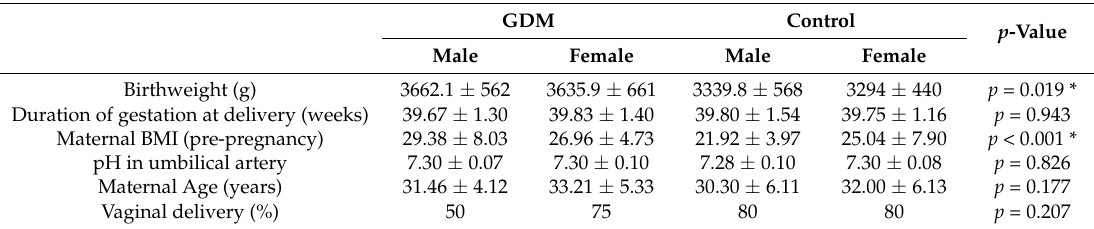
Table 1. Clinical and epidemiological data of study participants. The Kruskal–Wallis and Man-Whitney-U Tests were used for analysis of the